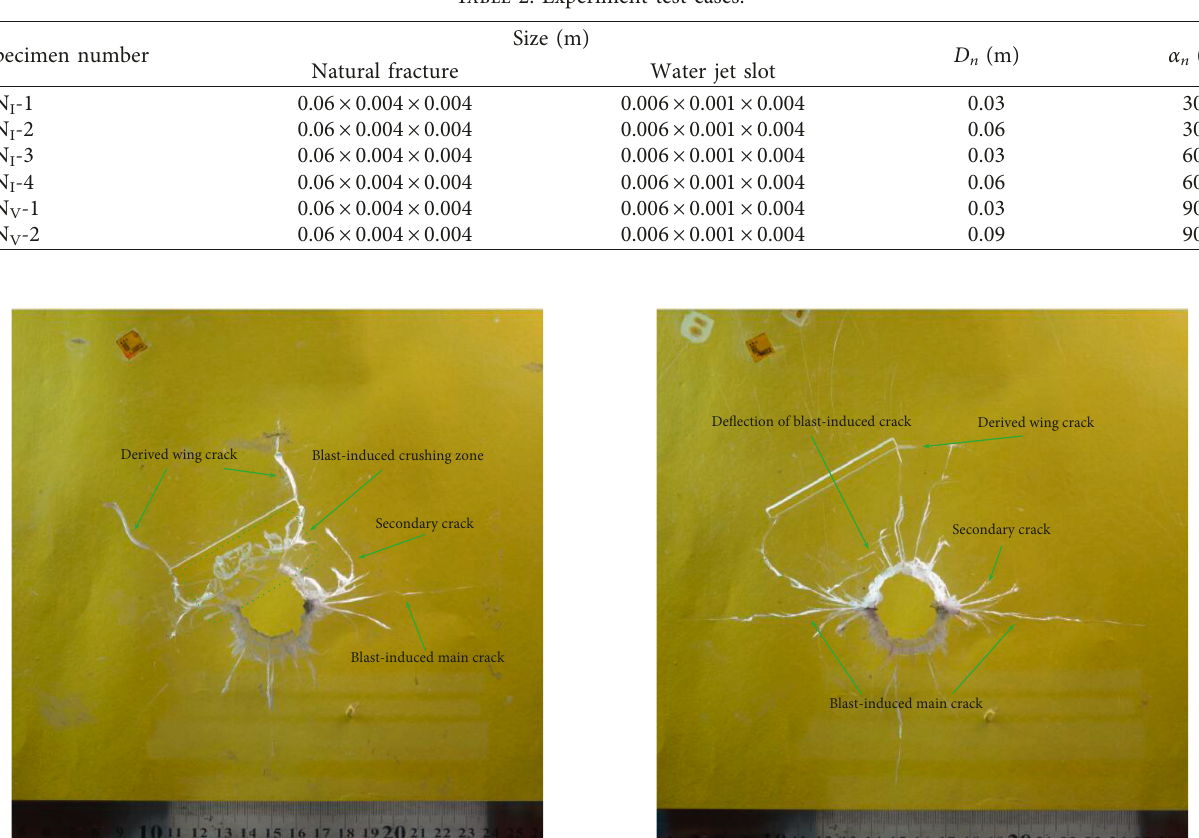
Table 2: Experiment test cases.